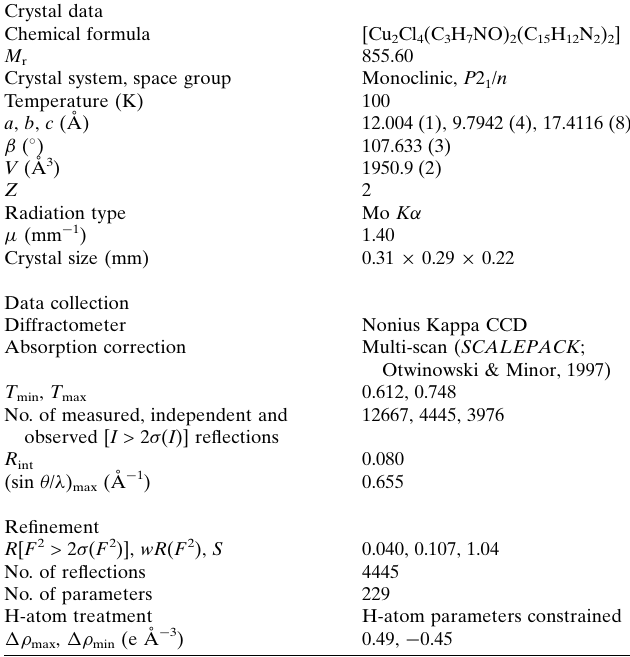
Table 2 Experimental details. Crystal data Chemical formula